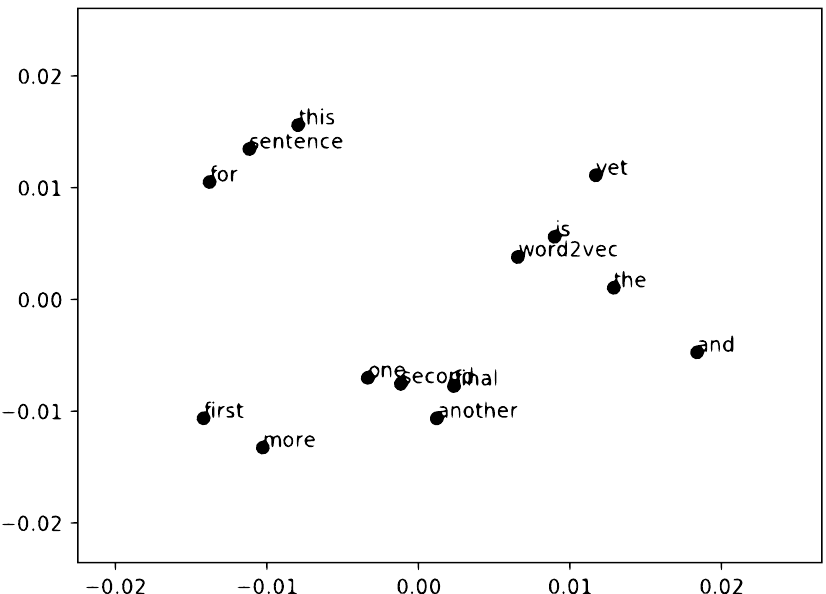
Figure 2. Word Embedding: the dots represent the word vectors contained in the word vector space related to a simple sentence.